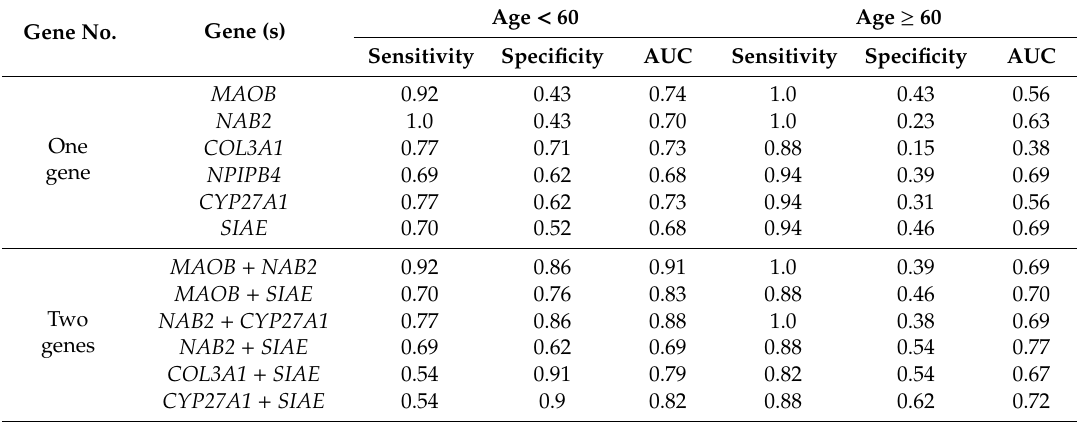
Table 4. Age-related Sensitivity, specificity, and AUC values for OSCC vs. control.